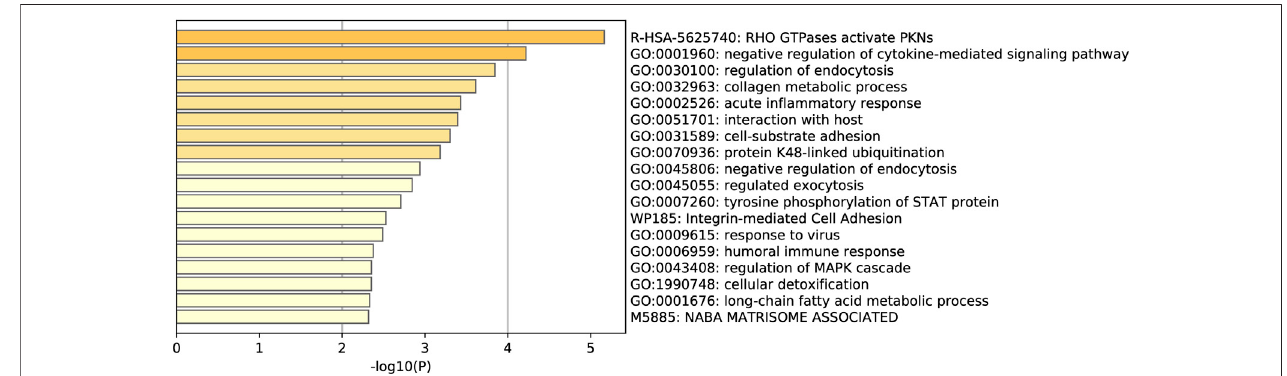
FIGURE 13 | List of gene terms enrichment for the upregulated COVID-19 genes in